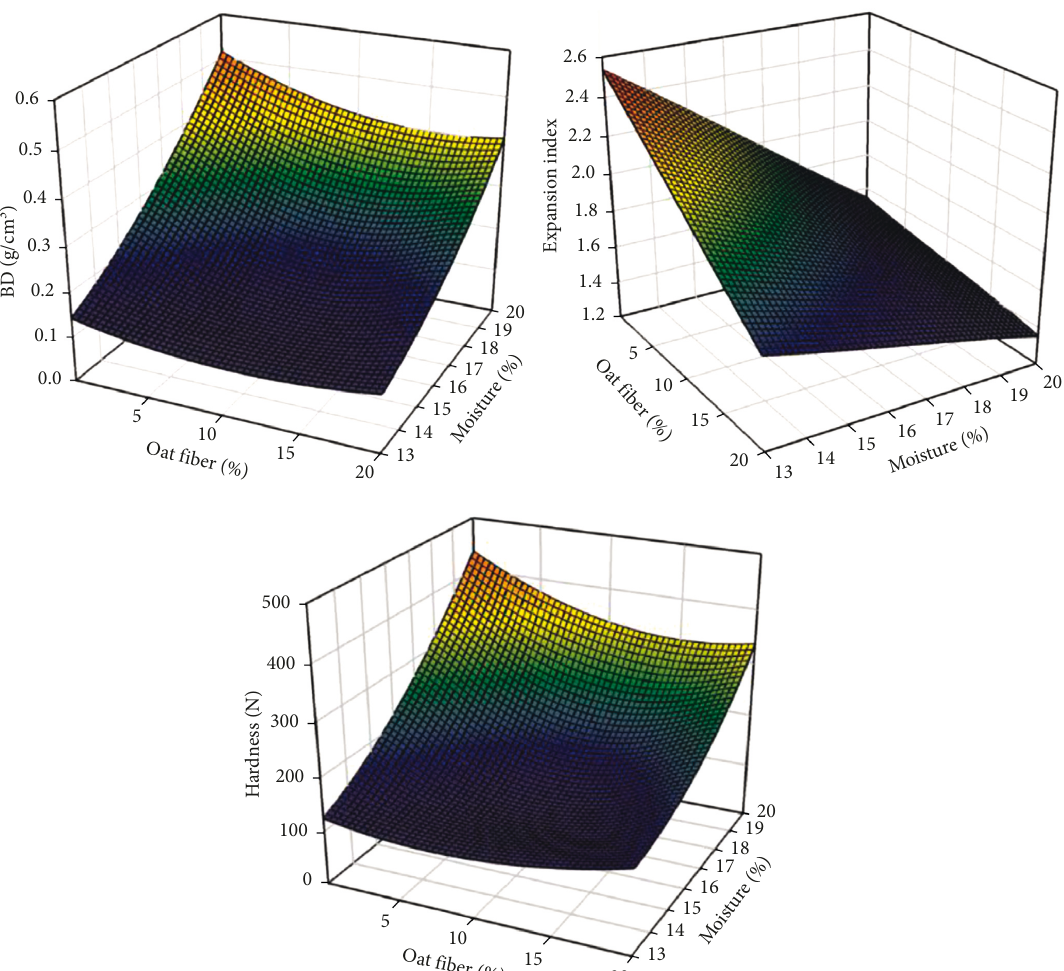
Figure 2: Effects of supplementation with different levels of oat fiber and tempering moisture content (%) on bulk density (BD “g/cm 3 ”), expansion index, and hardness ( N ) of the collets made from oca